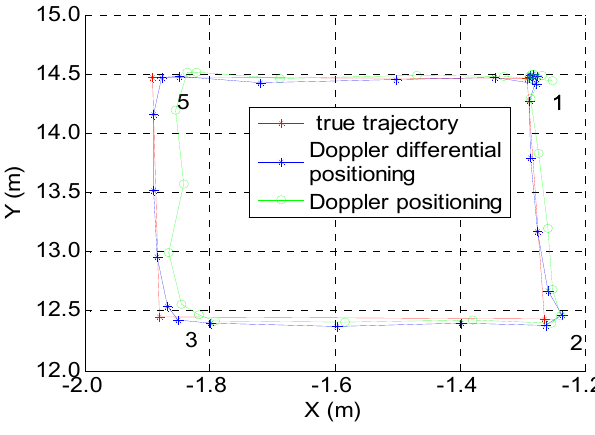
Figure 8. Kinematic test on a square trajectory. Table 4. Kinematic positioning error on a square trajectory.